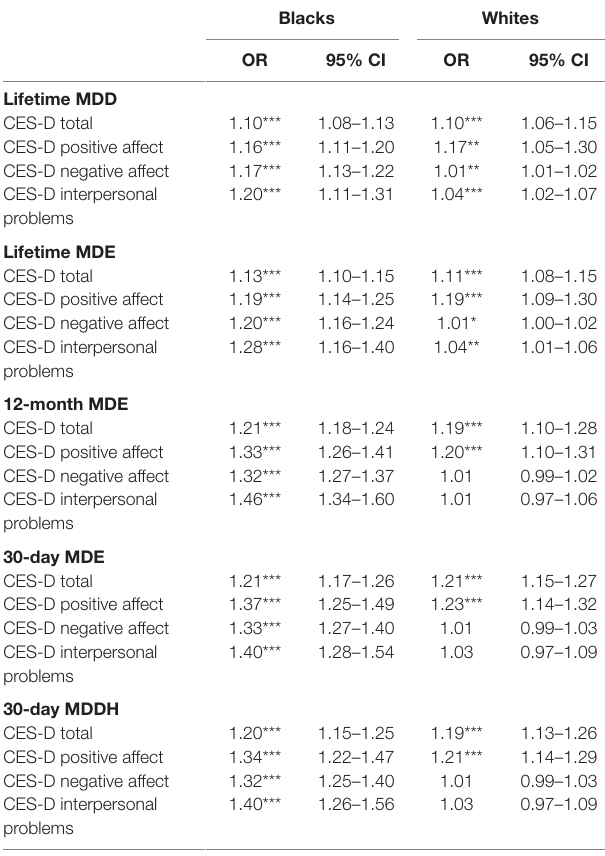
TaBle 2 | summary of regressions on the associations between ces-D factors and depressive disorders based on